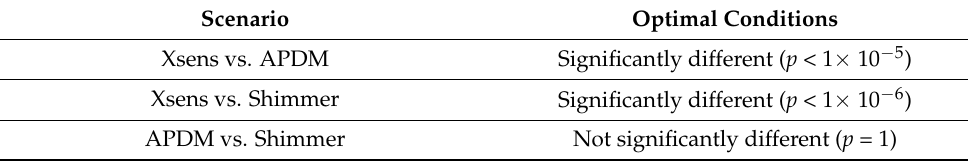
Table 8. Results of Friedman’s Test with Bonferroni’s Correction to Investigate the Differences among the Three Commercial Product Conditions.